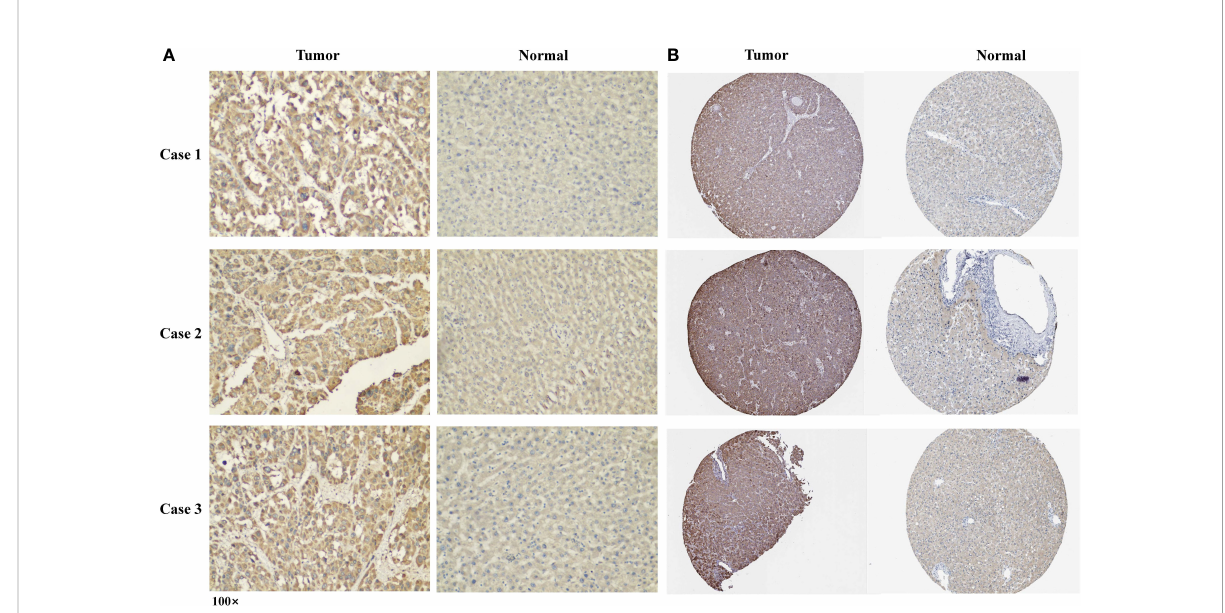
FIGURE 7 The expression of CLGN protein in HCC and adjacent tissues. (A) Three typical cases of CLGN protein upregulation in HCC in 24 clinical specimens. (B) The expression of CLGN protein in HCC is higher than non-cancerous liver tissue (HPA).